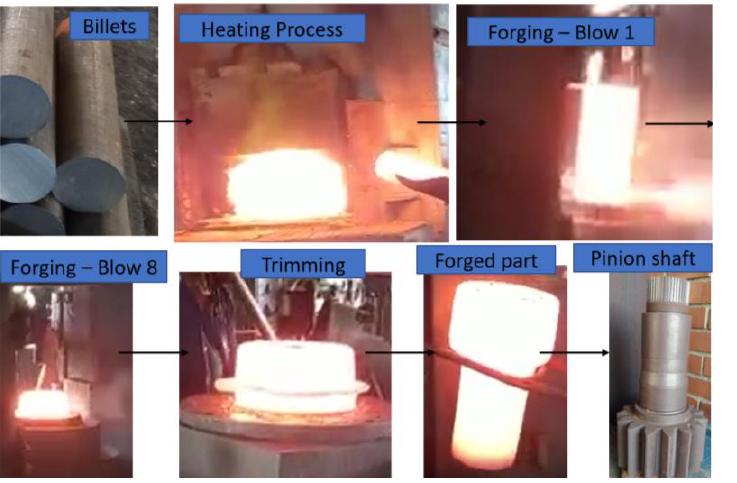
Figure 1. The hammering process flow.